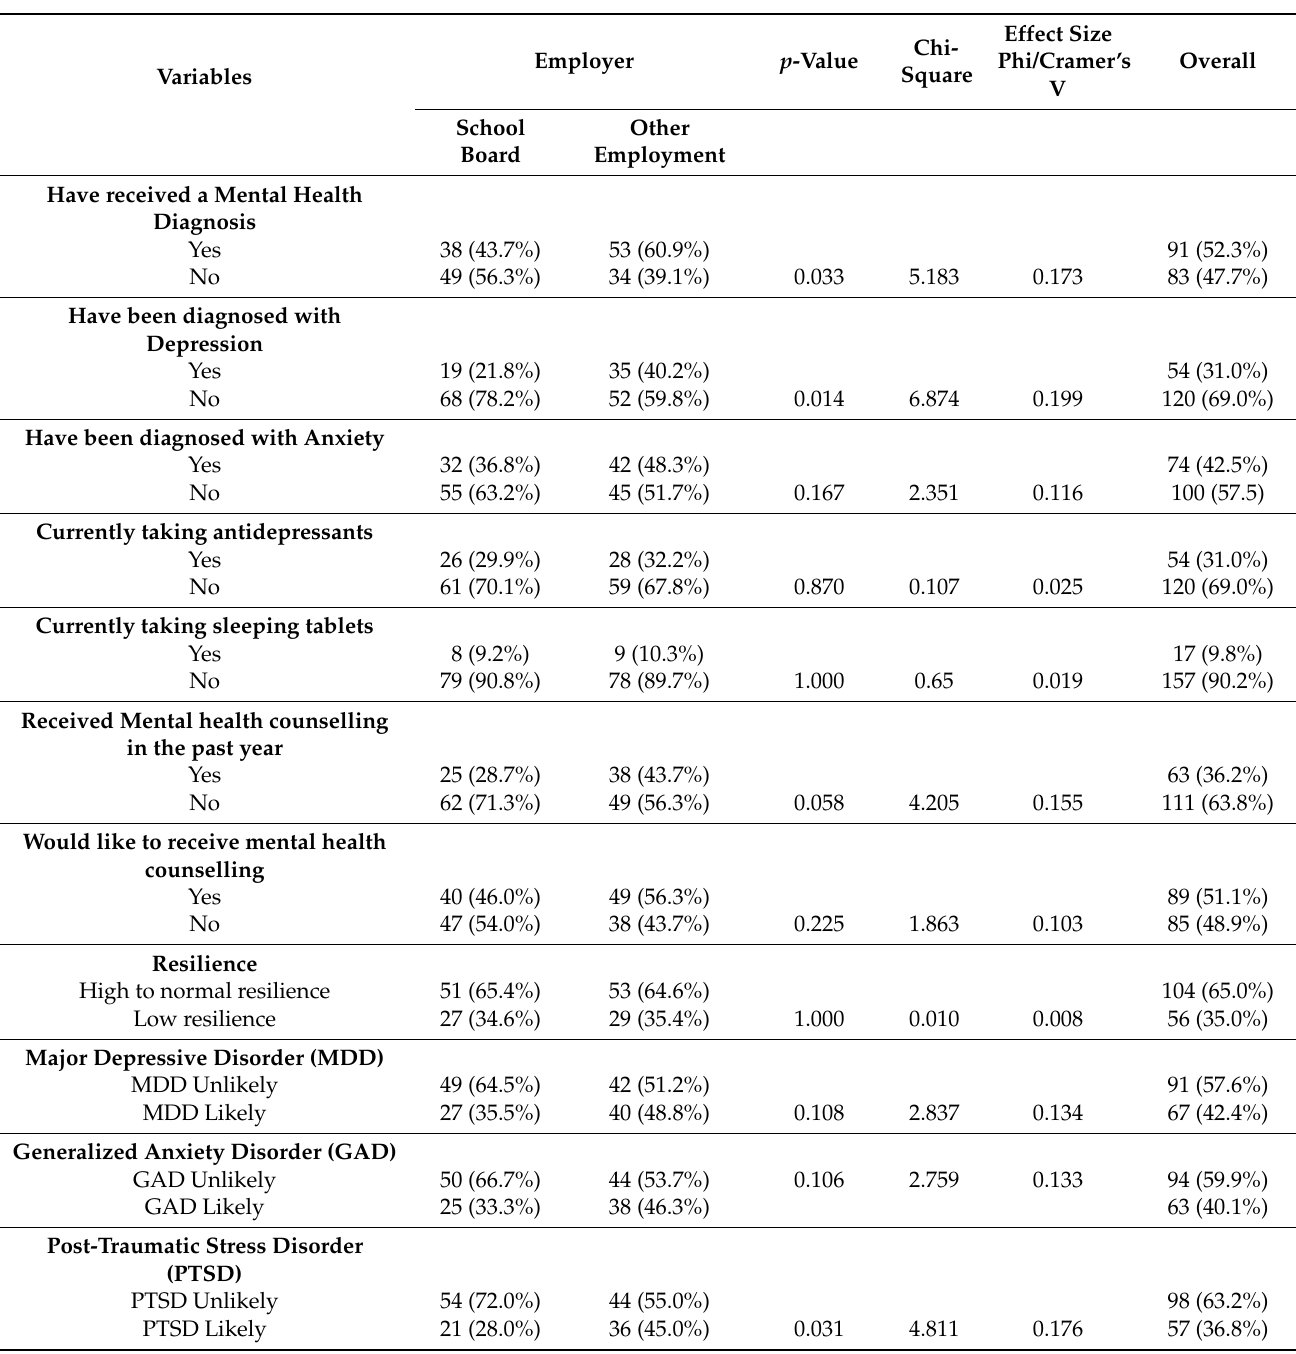
Effect Size Chi- Phi/Cramer’s Overall Square V